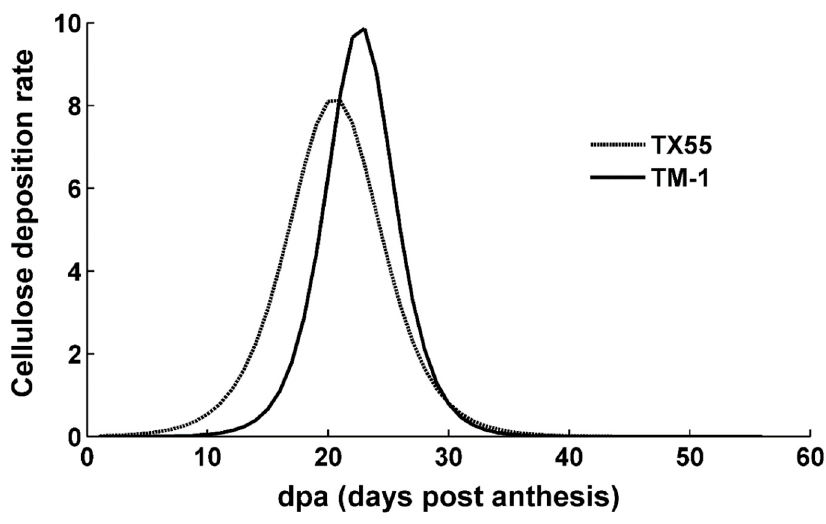
Figure 2. Cellulose deposition rate as a function of dpa from TX55 and TM-1 genotype.